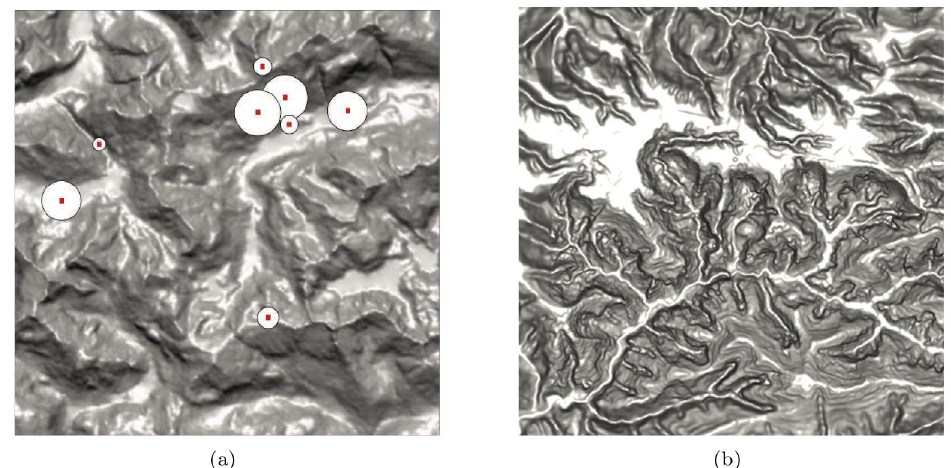
Fig 2. The principle of SVD based maximal Poisson-disk sampling for DEM simplification is shown in (a). The center of each disk is the final sample, which randomly appears at the DEM node. The disk’s radius is related to the local terrain variation. Moreover, one sample is only located in its related disk. Meanwhile, (a) and (b) are two data used in the following experiment.